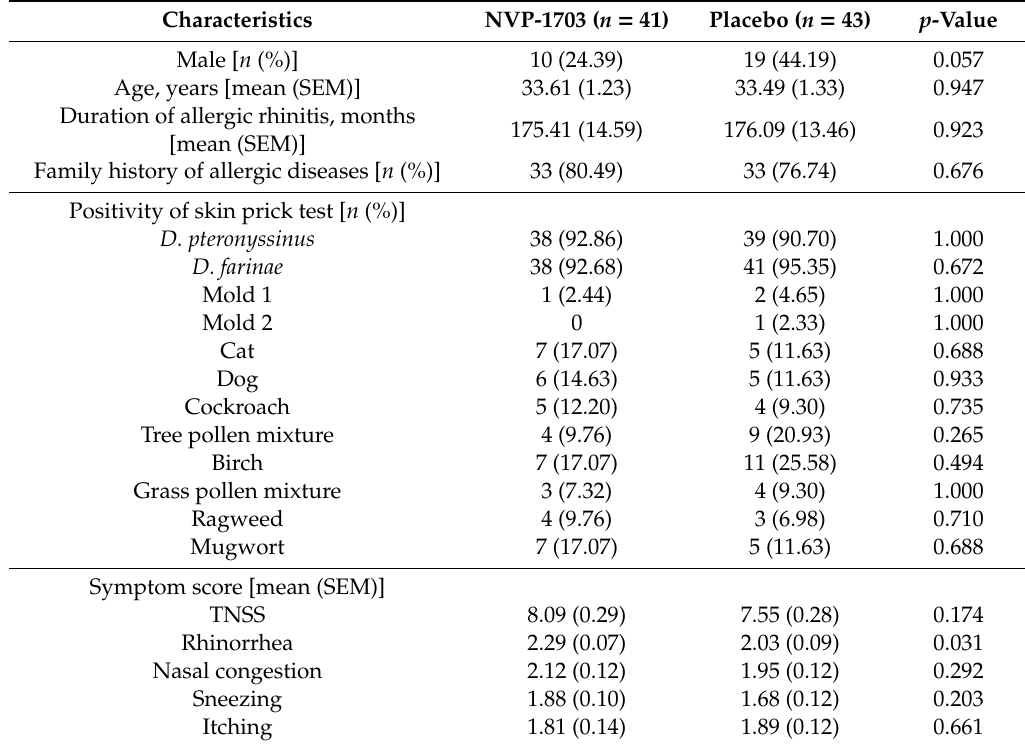
Table 1. Baseline characteristics of the study subjects.